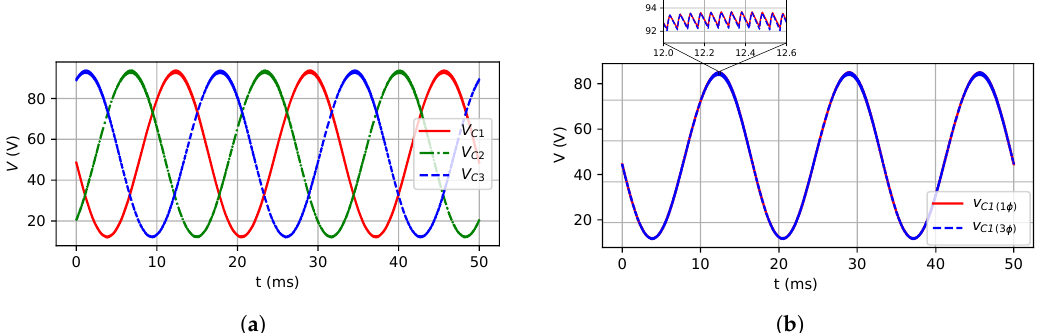
Figure 15. Capacitor voltages for RL load case: ( a ) Three-phase model; ( b ) Single-phase and three-phase (leg 1)